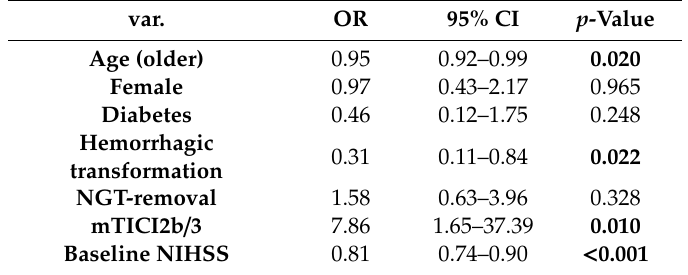
Table 4. Multivariable logistic regression for predictors of 180-day good outcome (mRS 0–2). var. OR 95% CI p -Value